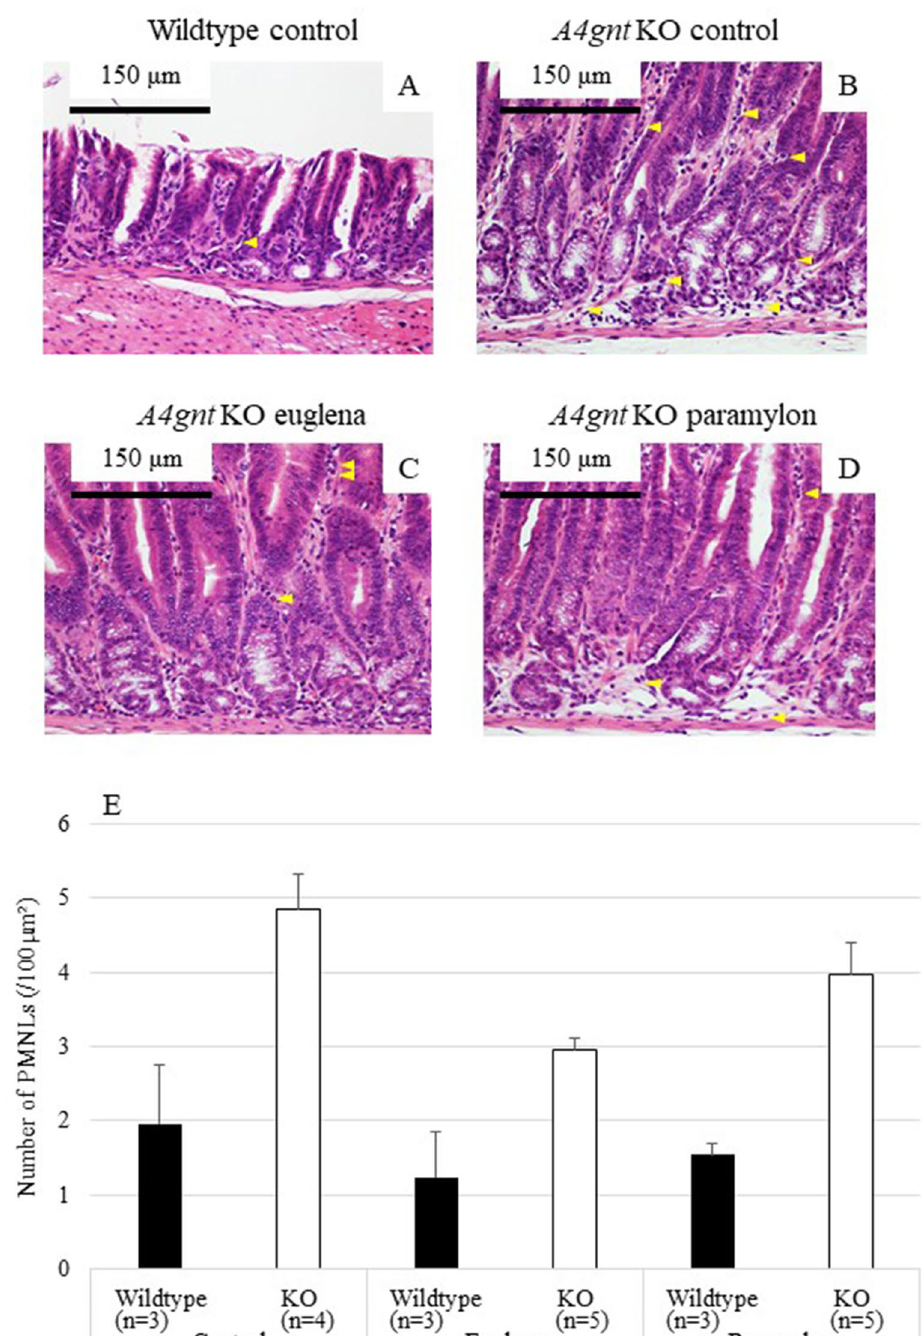
Figure 2. Numbers of PMNLs in pyloric mucosa of A4gnt KO and wildtype mice. ( A ) Wildtype mouse administered saline. ( B ) A4gnt KO mouse administered saline. ( C ) A4gnt KO mouse administered 50 mg/day of Euglena . ( D ) A4gnt KO mouse administered 50 mg/day of paramylon. Arrowheads indicate PMNLs. ( E ) Mean ± SD of numbers of PMNLs in pyloric mucosa. The mean number of PMNLs in gastric mucosa of A4gnt KO mice was significantly more than that of wildtype mice. Administration of Euglena significantly reduced the number of